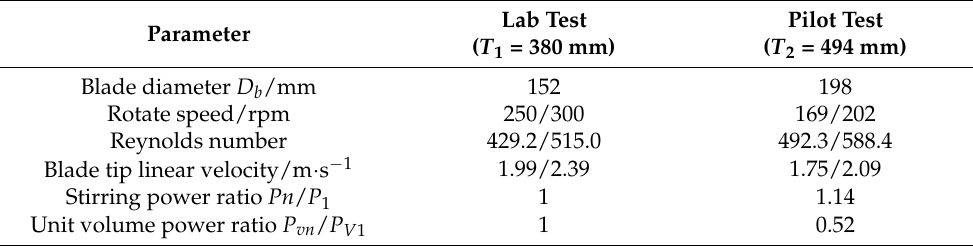
Table 7. Working condition parameters based on the same Weber